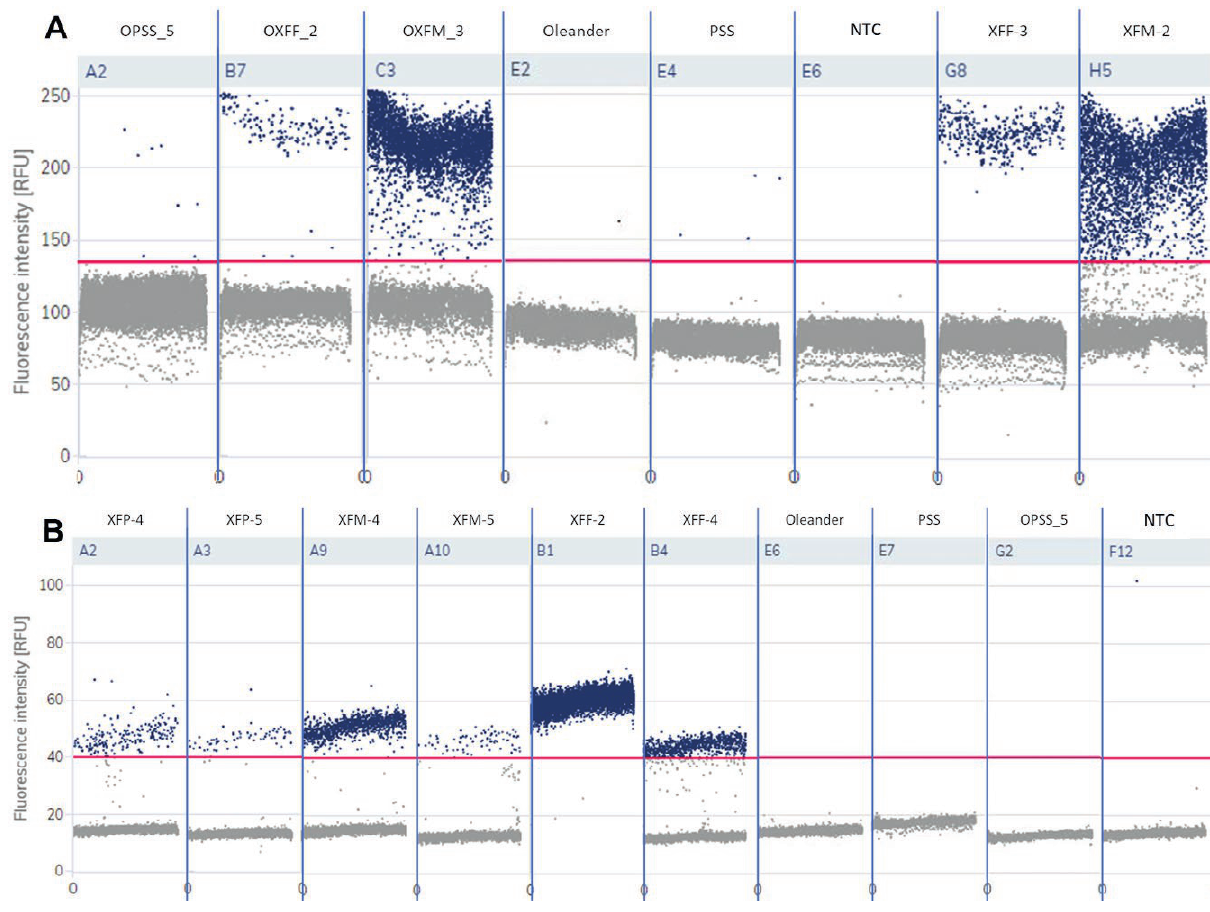
Figure 2. 1-D Scatterplots of representative samples for dPCR assays. Each box represents the fluorescence value (expressed as RFU) for each partition, the red line shows the threshold. Each partition above the threshold (in blue) is considered positive, while each below the threshold (in grey) is considered negative. A) Representative samples for the EG method, with threshold set at 135 RFU. This same dataset was also analysed with the threshold set at 200 RFU. B) Representative samples for the Probe method, with threshold set at 40 RFU. This same dataset was also analysed with the threshold set at 20